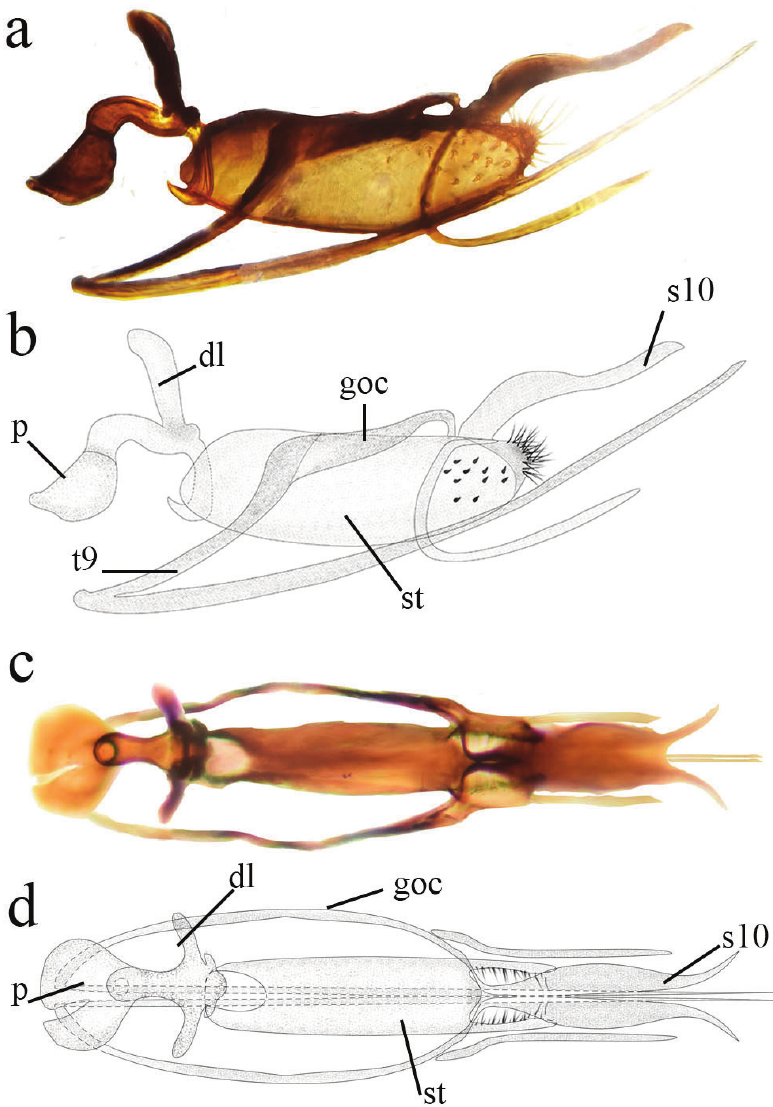
Figure 6. Heteroconis yunnanensis sp. nov., holotype male, genitalia a, b lateral view c, d dorsal view. p, pe- nis; s10, tenth sternite; goc, gonocoxite; dl, dorso-lateral projection of penis; st, stylus; t9, ninth tergite. complex with long hairs on inner surface, caudal ending with long hairs on prominent bases. Stylus about 3-times as long as broad in lateral view, with short and thick spines on distal third. Sternite 10 elongated, slightly sinuous in lateral view, caudal part lyriform in dorsal view. Basal apodeme of penis moderately developed, dorso-lateral projection rather small. Tube of penis rather thick between the basal and dorso-lateral projections, distal part slender, directed downwards and